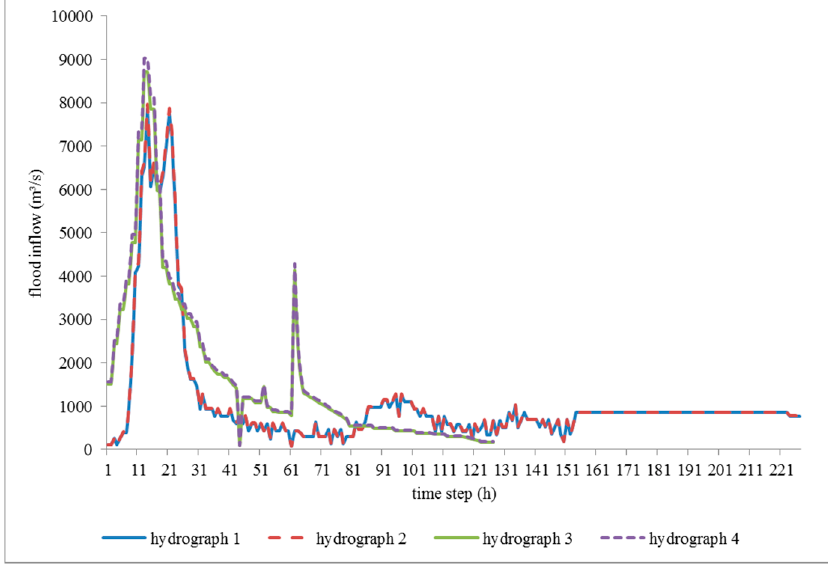
Figure 12. Simulated hydrographs of C or scenario.